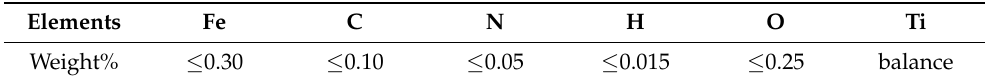
Table 2. Chemical composition of TA2 pure titanium.